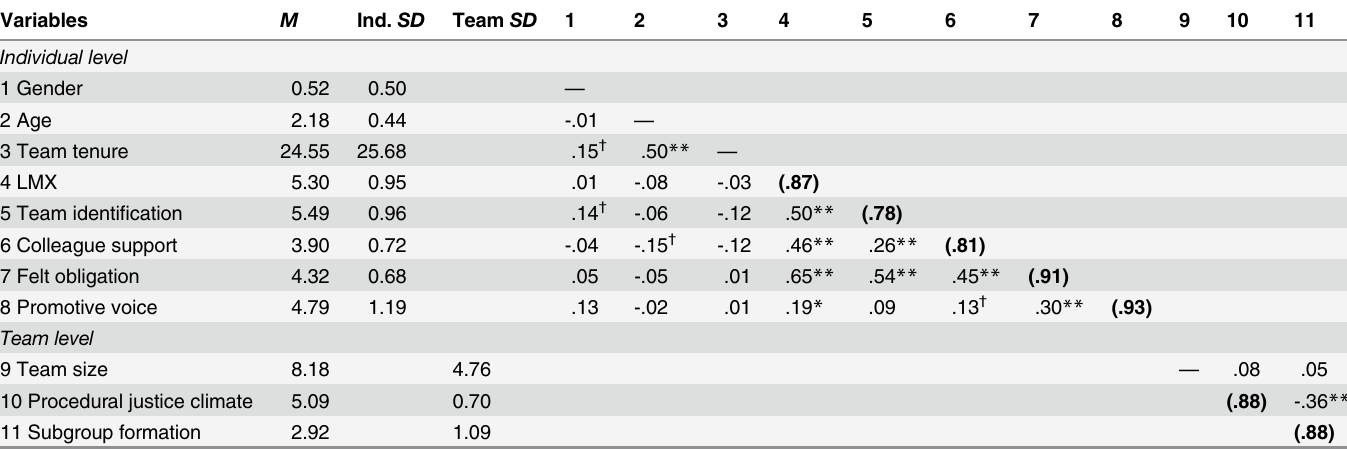
Table 2. Means, standard deviations, and bivariate correlations among studied variables.